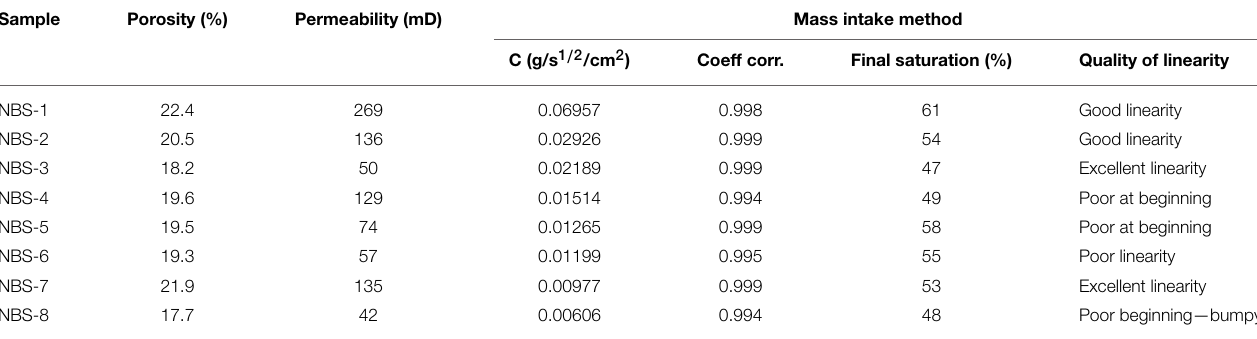
TABLE 1 | Petrophysical properties and coefficient of capillarity C of the Nubia sandstone samples obtained with the mass intake method.